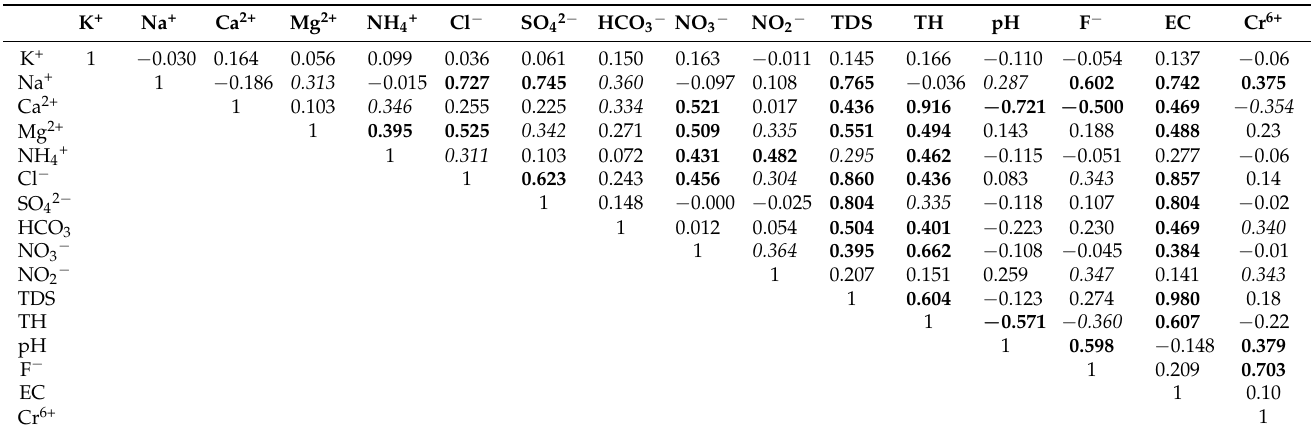
Table 3. Pearson correlation matrix between physicochemical parameters of water samples.